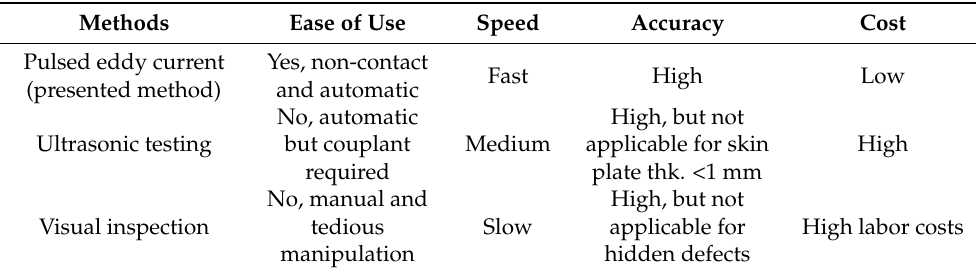
Table 3. Performance comparison of NDT methods for inspecting SS core